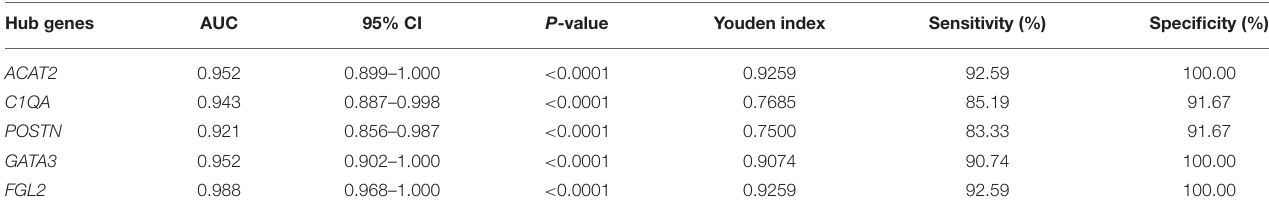
TABLE 3 | Receiver-operating characteristic curve analysis of five hub genes for IgAN. Hub